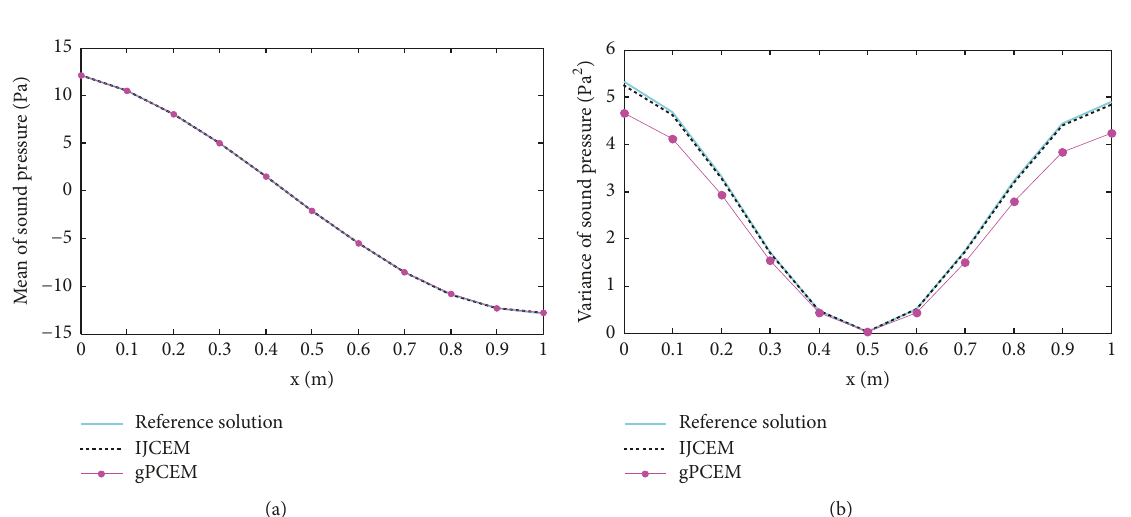
Figure 4: Mean and variance of the sound pressure’s imaginary parts of acoustic tube along the central axis at f=150Hz: (a) mean and (b)